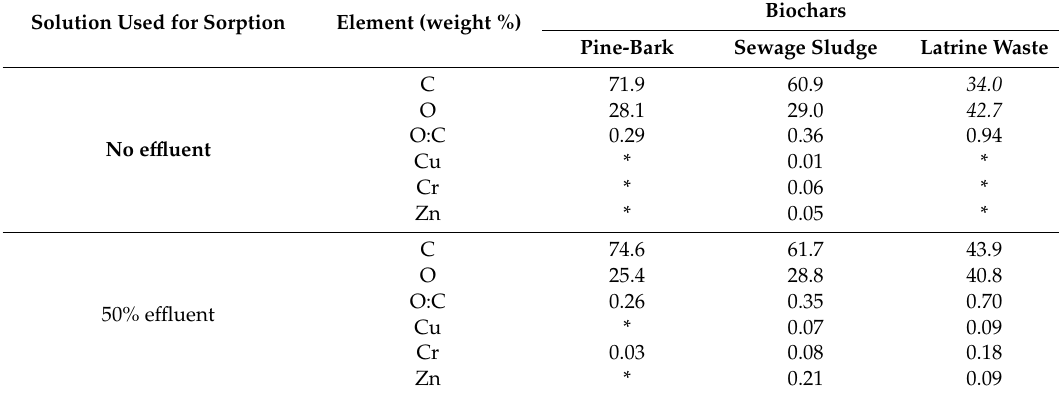
Table 4. Concentrations of carbon, oxygen, copper, chromium and zinc (%) on biochar types pyrolysed at 350 ◦ C after sorption study with or without e ffl uent.